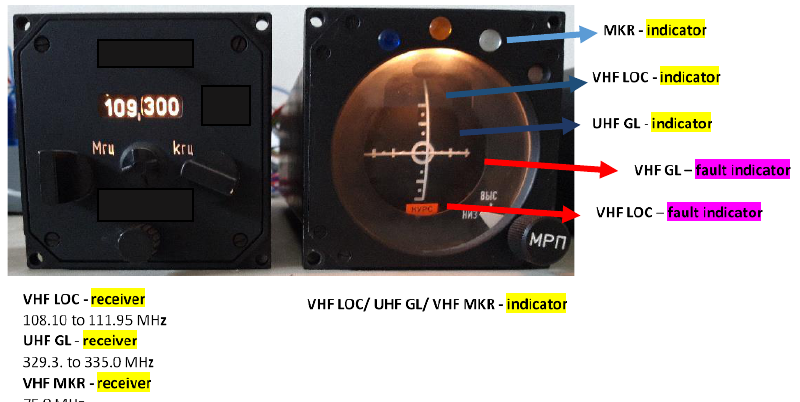
Figure 10. Normal ILS/glide path (GP) indication.